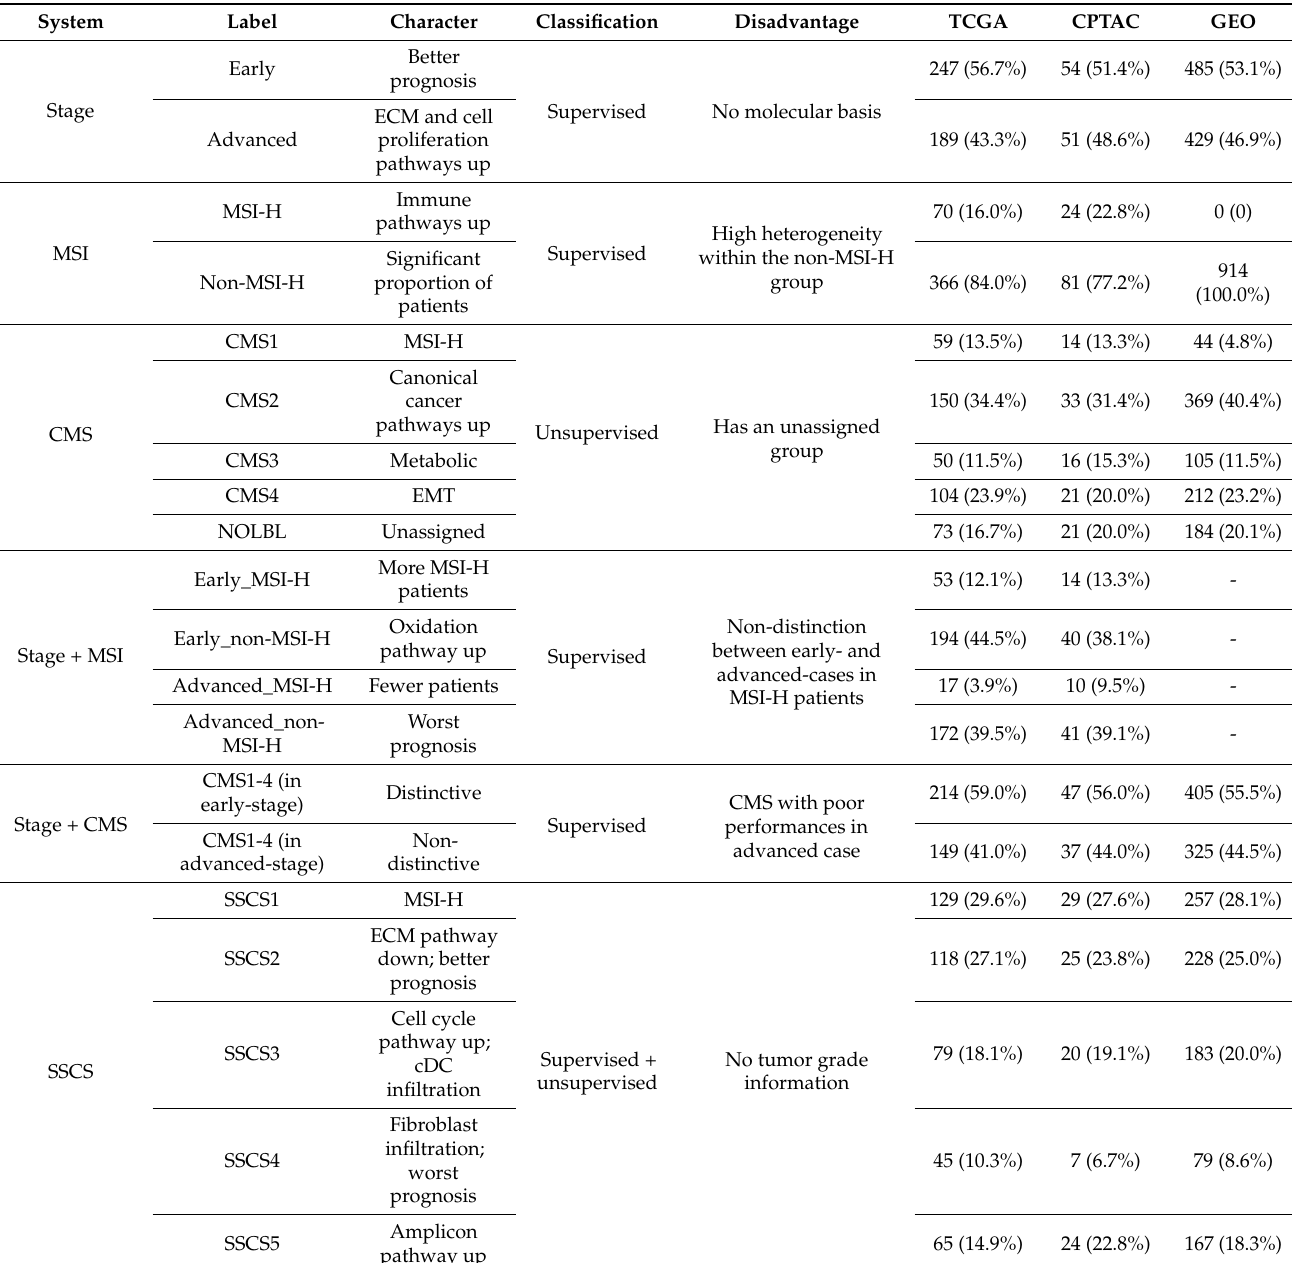
Table 1. Patient’s distributions from three previous CRC subtyping